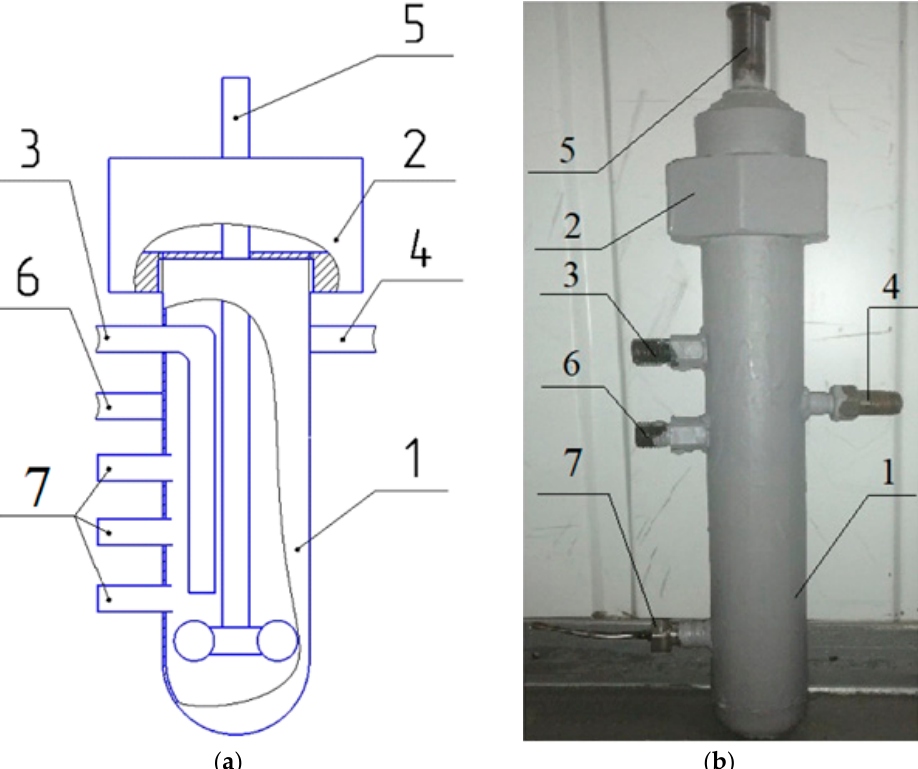
Figure 3. Schematic diagram ( a ) and actual design ( b ) of the pyrolysis reactor, where: 1—metal flask; 2—metal lid; 3—inlet pipe for hydrocarbon gas; 4—outlet pipe for gaseous pyrolysis products; 5—stirrer; 6—inlet pipe for catalyst; 7—thermocouple.